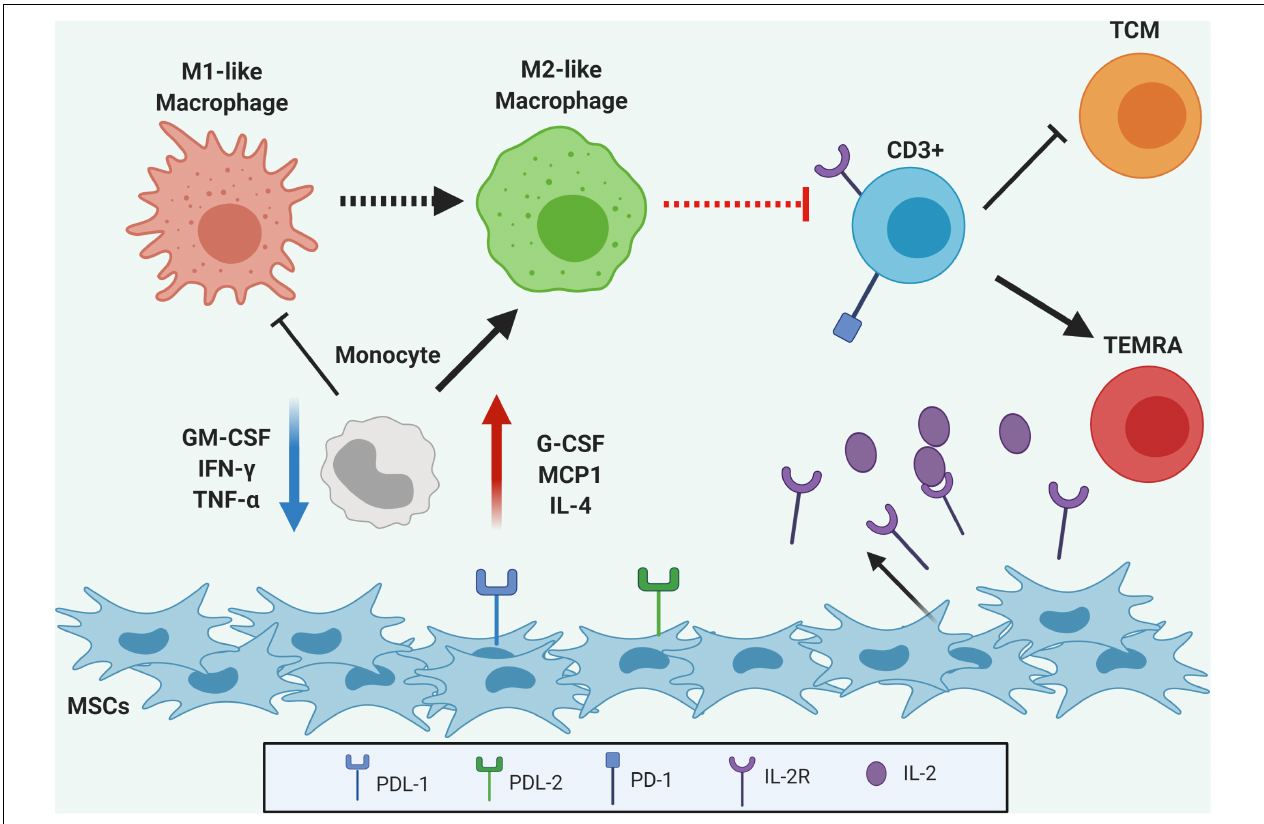
FIGURE 8 | Graphical abstract. UC-MSC are able to modulate monocyte differentiation toward M2-like macrophages via secretion of multiple cytokines to the extracellular media. Additionally, a concomitant action of induced M2-like macrophages and UC-MSC secretion of IL-2R and expression of PD-L1 and PDL-2 on the extracellular membrane produce regulation of activated CD3+ T cells, reducing the pool of effector cells and inducing terminally differentiated phenotype.